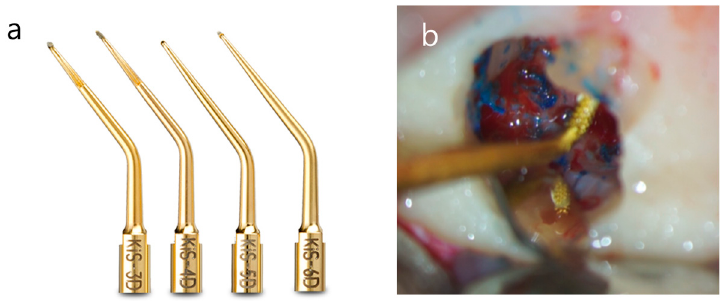
Figure 17. ( a ) Diamond-coated ultrasonic tips with various angles (Microsurgical KiS tips). 3D and 5D for buccal canals. 4D and 6D for lingual canals. (Image courtesy of Young Specialties, https://www.youngspecialties.com/product/kis-ultrasonic-tips-1-ct, accessed on 27 January 2021) ( b ) Retrograde cavity preparation for mesial root-end of a mandibular first molar with JETip.